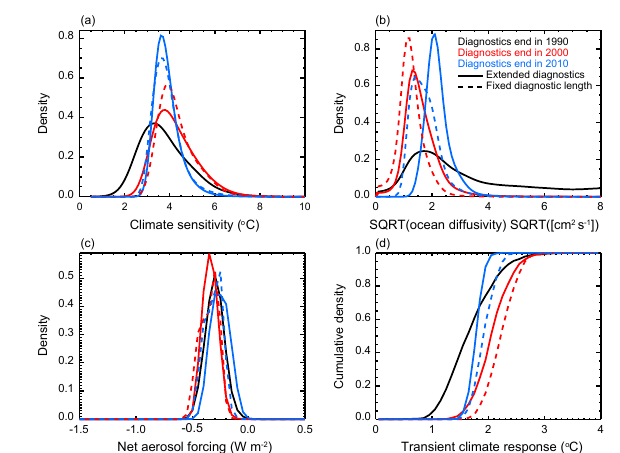
Figure 11. Marginal probability distribution functions for (a) ECS, √ K v , and (c) F aer , and (d) cumulative distribution function for (b) TCR when changing the end date of model diagnostics. Distribu- tions with diagnostics ending in 1990 (black), 2000 (red), and 2010 (blue) are shown. Solid lines indicate an extension of the diagnostic and dashed lines indicate that the lengths of the diagnostics remain fixed when incorporating more recent